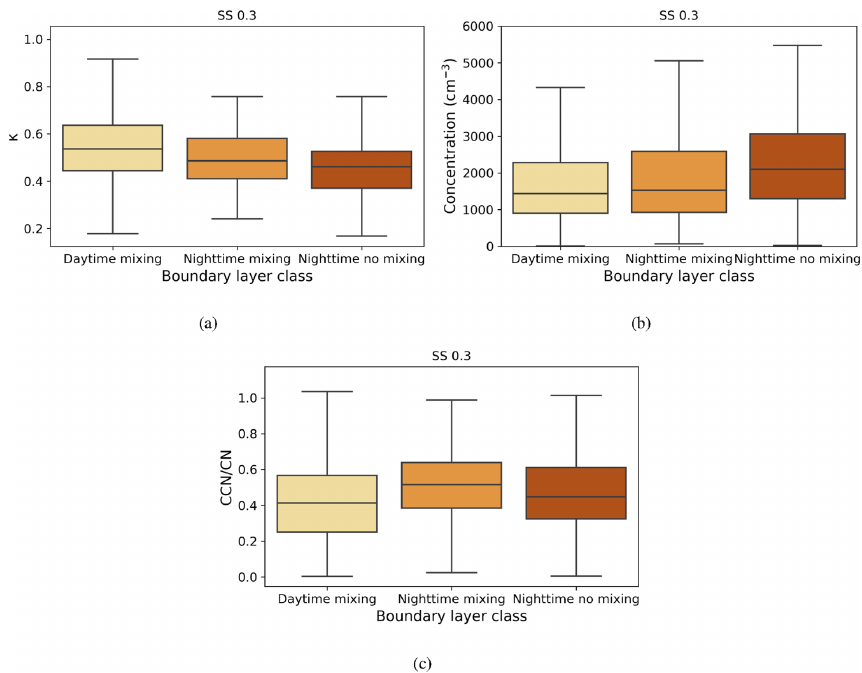
Figure 7. Box-and-whisker plots of hourly median values for three boundary layer conditions for (a) κ parameter, (b) CCN number con- centration (cm − 3 ), and (c) activation fraction (CCN/CN) at a supersaturation of 0.3. The central line in each box indicates the median, and the bottom and top lines of the boxes indicate the 25th and 75th percentiles. The whiskers mark the most extreme data points that are not considered to be